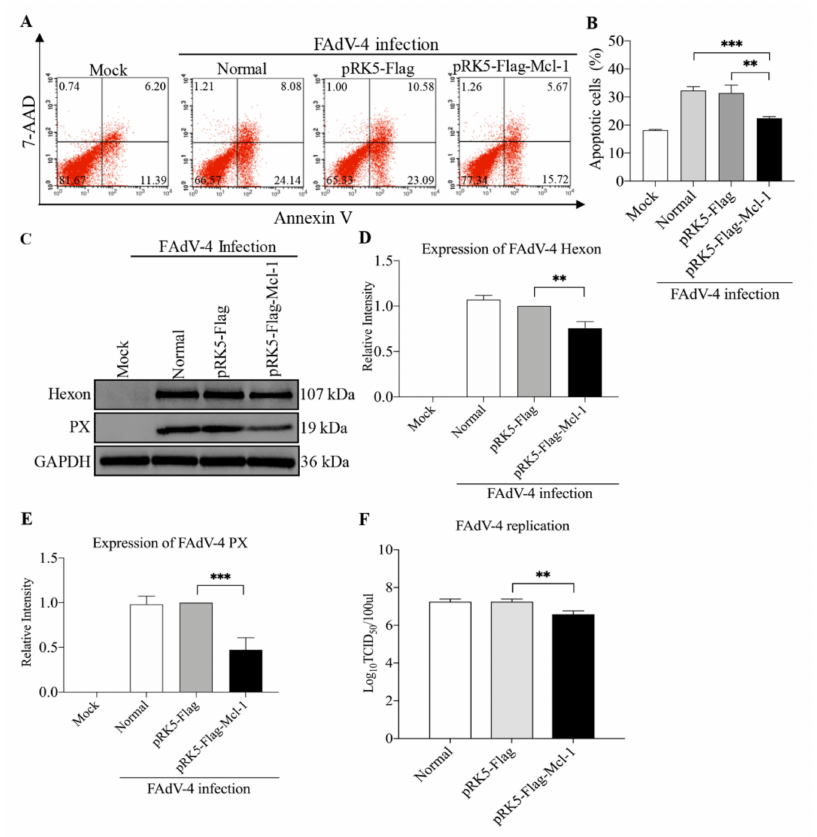
Figure 7. The overexpression of Mcl-1 inhibited FAdV-4-induced apoptosis and suppressed FAdV-4 replication. ( A , B ) The overexpression of Mcl-1 inhibited FAdV-4-induced apoptosis. The LMH cells were transfected with pRK5-Flag-Mcl-1 or controls. Twenty-four hours after transfection, the cells were infected with FAdV-4 at an MOI of 1. Forty-eight hours after FAdV-4 infection, the cells were collected, stained with Annexin V-PE and 7-AAD, and examined for apoptosis by flow cytometry ( A ). The percentage of apoptotic cells in each group in panel ( A ) was graphed and statistically analyzed ( B ). ( C – E ) The overexpression of Mcl-1 suppressed FAdV-4 replication. LMH cells were treated as described above. Twenty-four hours after transfection, the cells were infected with FAdV-4 at an